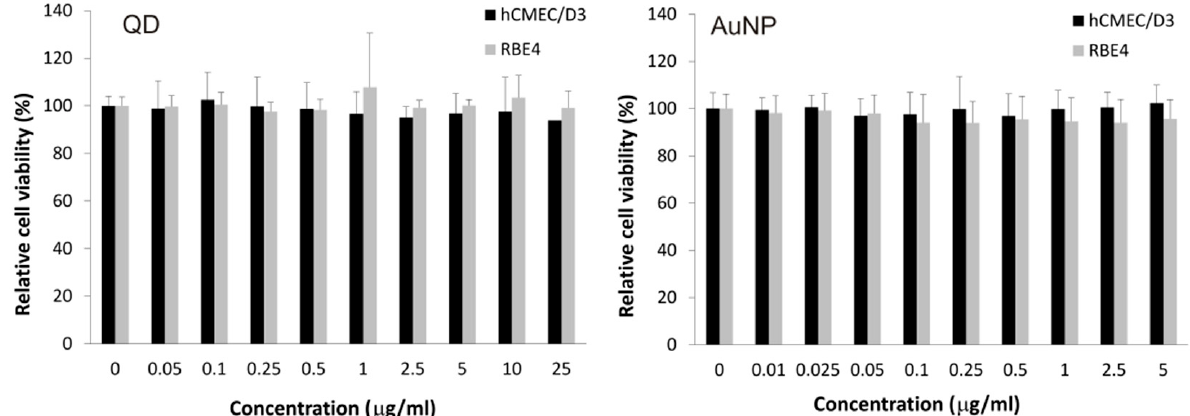
Figure 2. Survival of brain microvascular endothelial cell lines exposed to nanoparticles (QD and AuNP). Cell viability (for hCMEC/D3 and RBE4 cell lines) was assayed by the resazurin method, calculated as the rate of resazurin reduction by viable cells and presented as a percentage of the value for control (non-exposed) cells. Data shown as average ± S.D. ( n = 6), no differences between depicted values were statistically significant at p < 0.05.